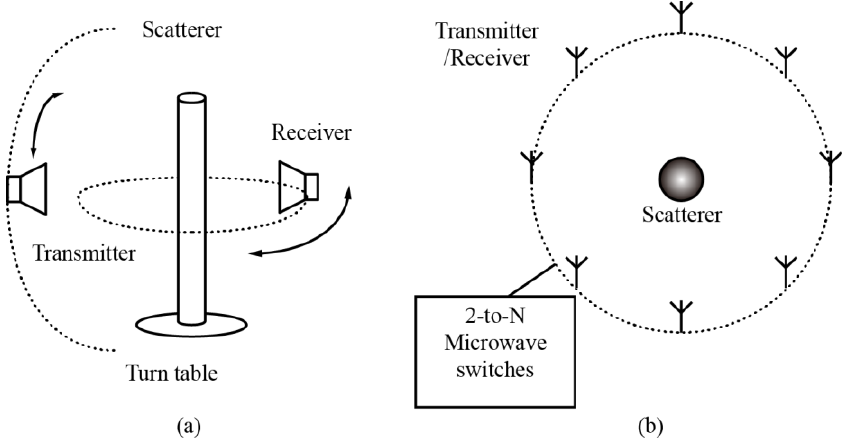
Figure 1. Typical setups for inverse scattering problem based microwave imaging. ( a ) Mechanical turning system; and ( b ) an electronically-controlled system with a 2-to-N microwave switching network.